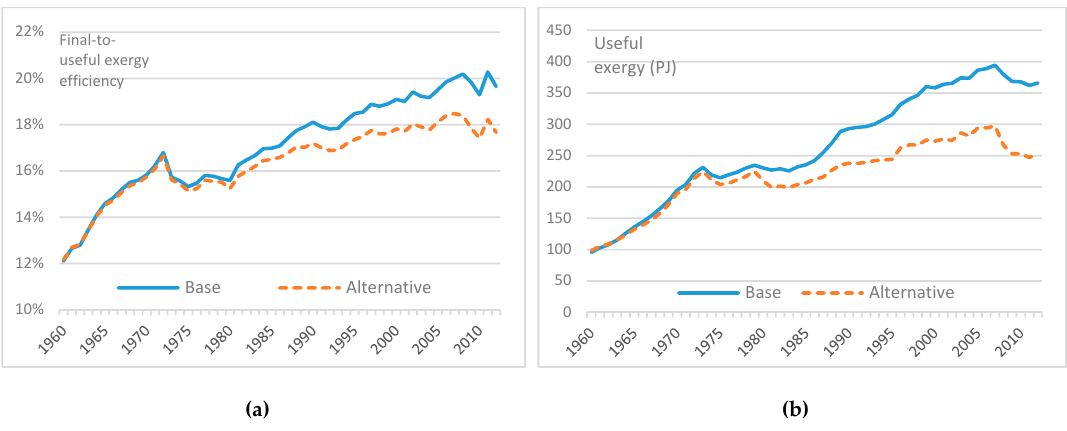
Figure 7. Results using base and alternative methods for mechanical drive efficiency estimation: ( a ) National final-to-useful exergy efficiency; ( b ) Total mechanical drive useful exergy consumption.